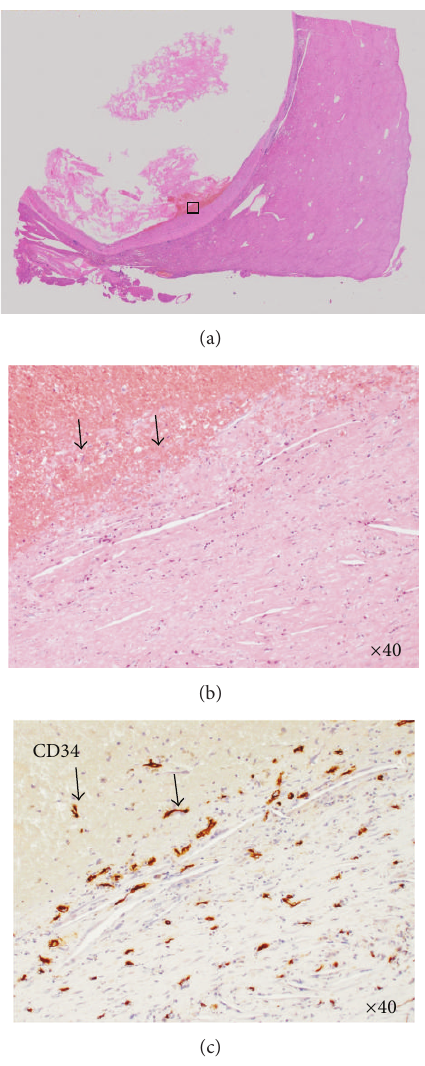
Figure 6: Histopathological images. (a) HE: magnified image, (b) HE: image × 40 magnification, (c) CD34: image × 40 magnification.